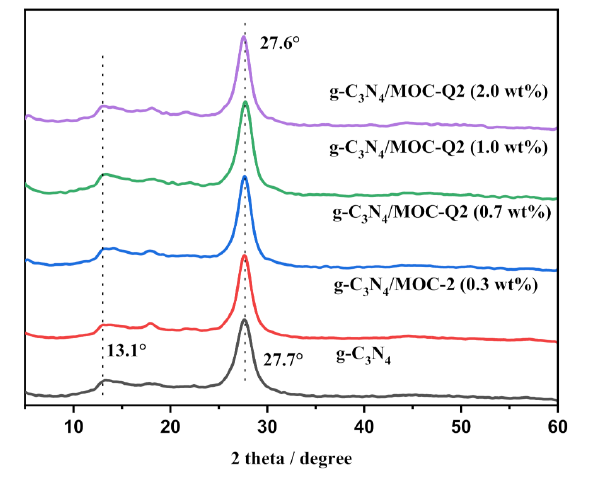
Figure 1. The XRD patterns of g-C 3 N 4 and g-C 3 N 4 /MOC-Q2 (0.3/0.7/1.0/2.0 wt%).